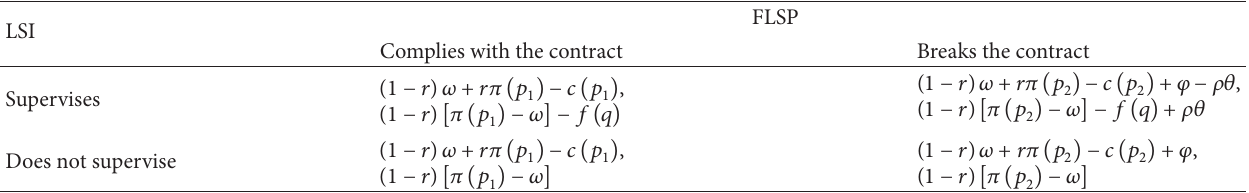
Table 1: Expected revenue matrix of the LSI and the FLSP.